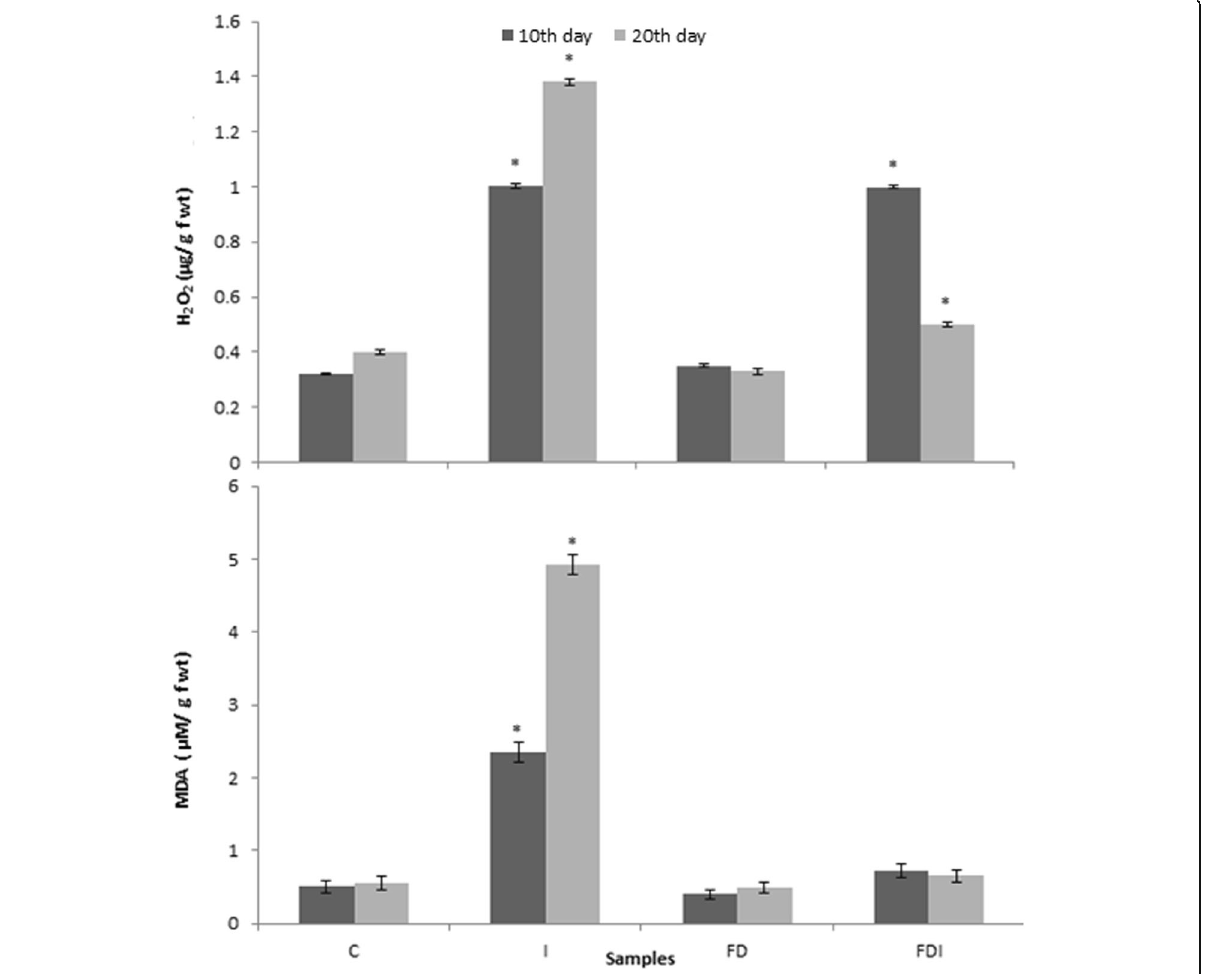
Fig. 2 Effect of defensin priming on oxidative stress markers (MDA and H 2 O 2 ) in plants under Fusarium infection. C: control plants (plants grown from non-primed grains in non-infected soil, FD: plants grown from defensin-primed grains in non-infected soil, I: plants grown from non-primed grains in Fusarium-infected soil and FDI: plants grown from defensin-primed grains in Fusarium-infected soil. The columns followed by asterisks are significantly different from the control according to paired-sample t test. The bars represent the standard error. Values are means of three